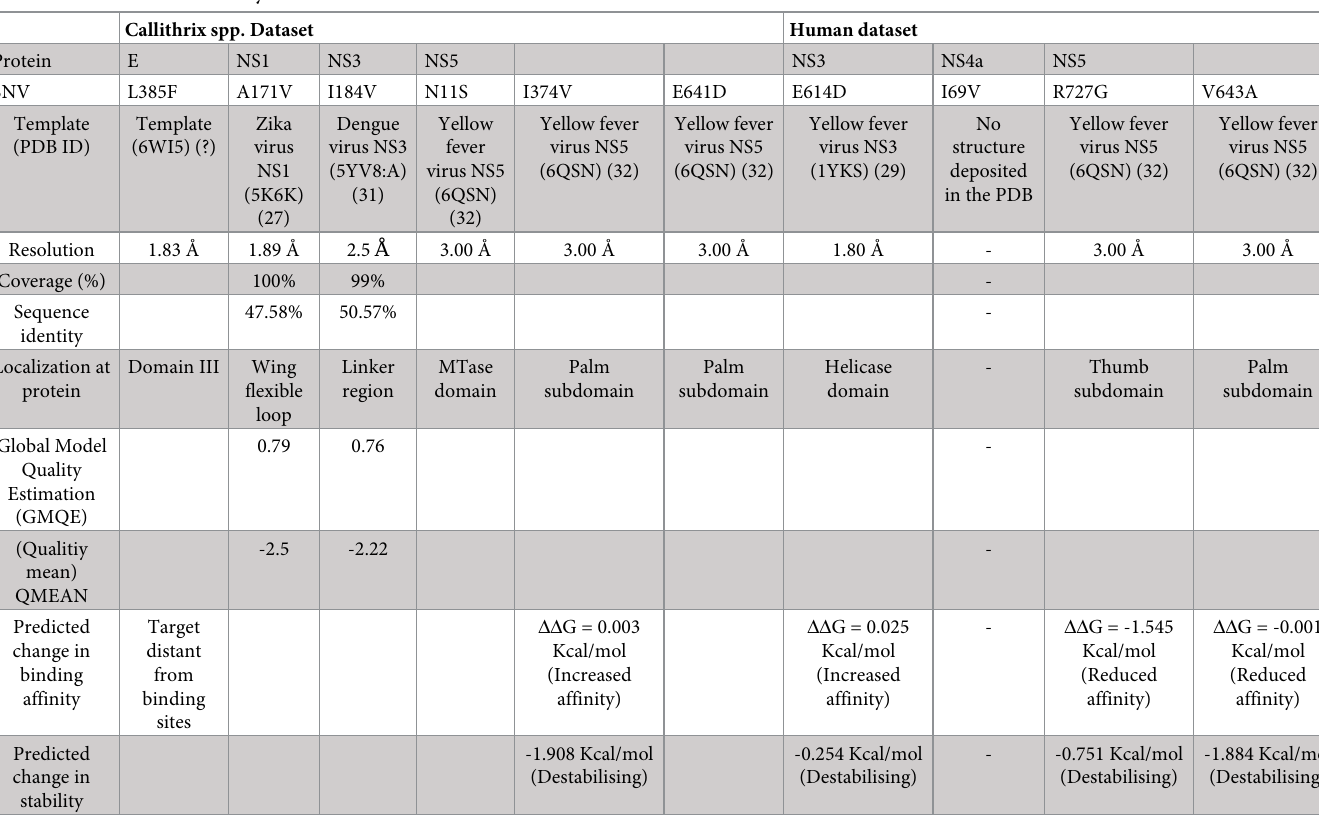
Table 2. Protein structural analysis